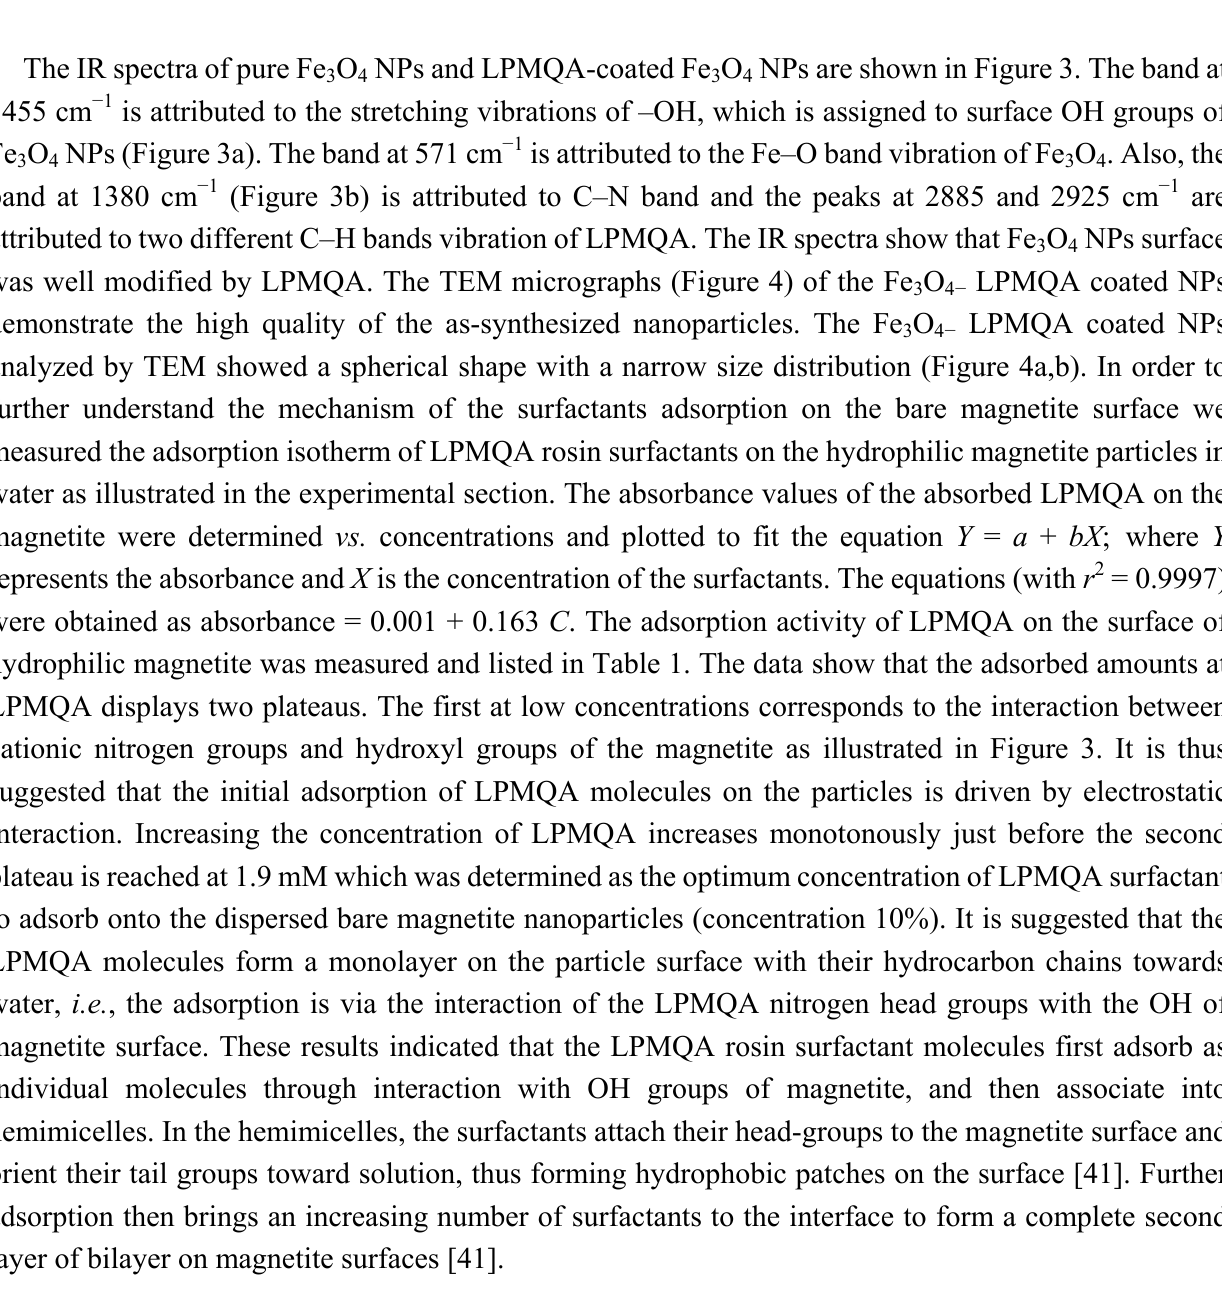
O NPs coated with 3 4